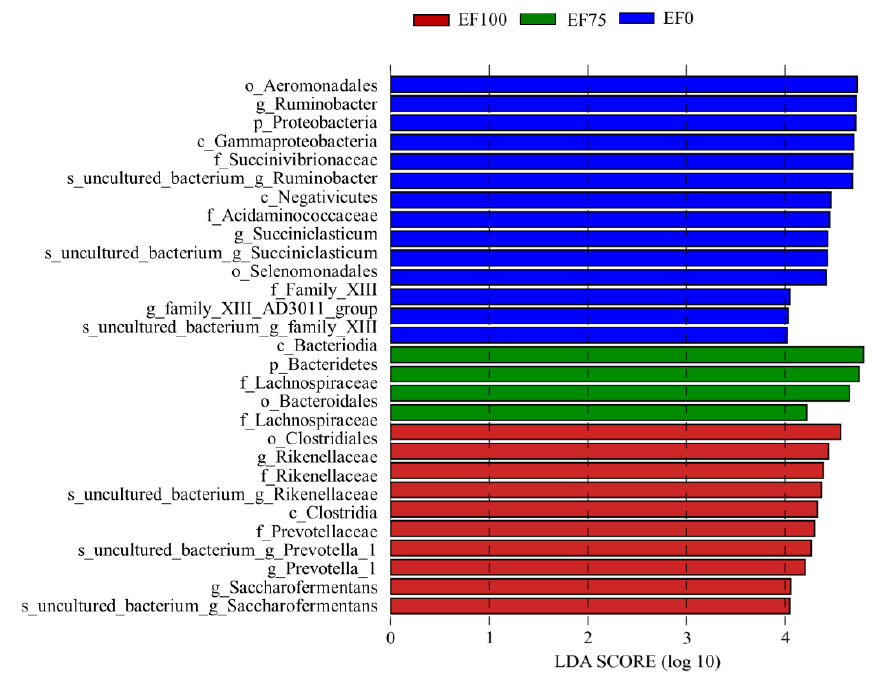
Figure 5. Bacterial taxa with linear discriminant analysis (LDA) that score greater than four in rumen microbiota of sheep with different treatments. EF0, EF25, FE50, EF75, and EF100 are defined as EF replacement ratios of 0%, 25%, 50%, 75%, and 100% of the fermentation substrate, respectively.